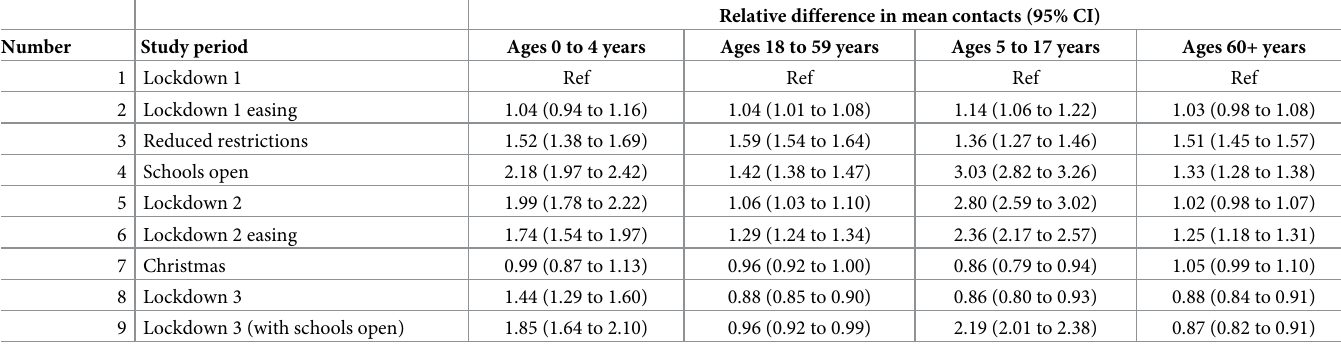
Table 4. Relative difference in mean contacts by study period with 95%